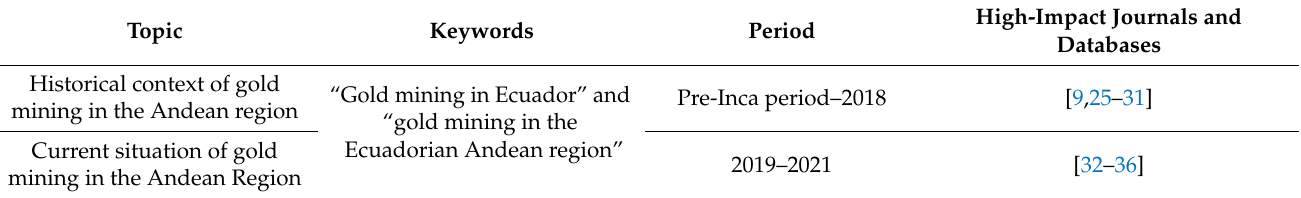
Table 2. Selection process and literature review.